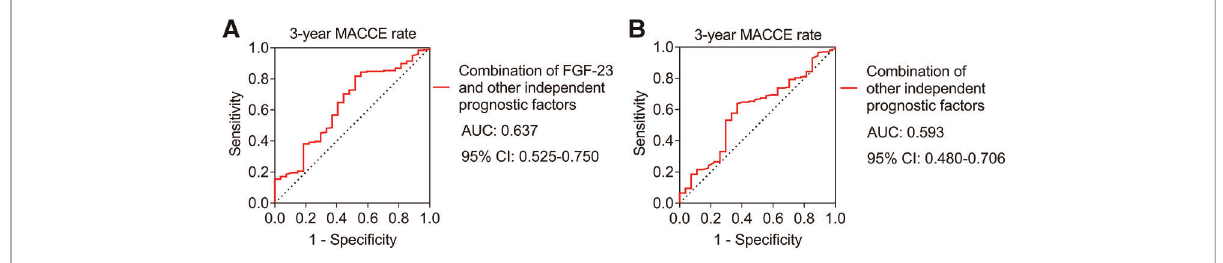
TABLE 3 Multivariate Cox ’ s proportional hazards regression analysis for cumulating MACCE rate. Items P Serum FGF-23 level before surgery (high vs.